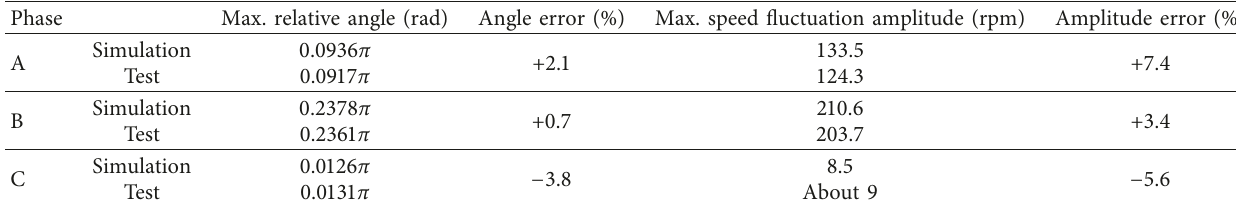
Figure 10: Testing DMF angle Table 2: Simulation and test data comparison and relative errors.